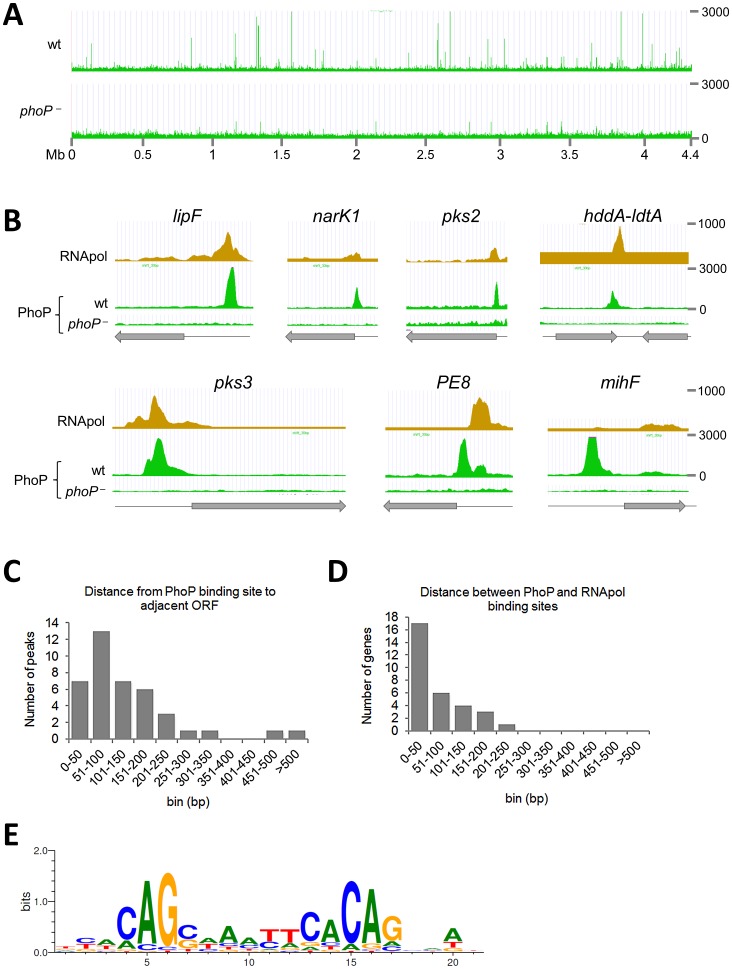
Mapping of PhoP binding sites in the M. tuberculosis chromosome by ChIP-seq.
A. UCSC genome browser view showing PhoP binding regions across the M. tuberculosis genome. Peak height correlates with sequence reads and consequently with PhoP binding affinity. The use of a phoP mutant in this experiment (bottom panel) allows identification of false positive signals. B. PhoP and RNA polymerase (RNApol) ChIP-seq profiles for selected genes. Note that the PhoP binding site lies upstream that of RNApol for lipF, narK1, pks2 and pks3, known to be transcriptionally activated by PhoP. The position of the PhoP binding region lies downstream that of RNApol for the PE8 gene. PhoP binding at the 3′-end of hddA is shown as an example of non-canonical target. C. Bar diagram showing distance (in bp) between the PhoP binding sites and the start codon of adjacent ORFs. D. Bar diagram showing distance between the position of the PhoP binding site and the summit of the RNApol peak calculated from ChIP-seq data. E. Sequence logo showing the consensus sequence derived from the PhoP binding sites identified by ChIP-seq.